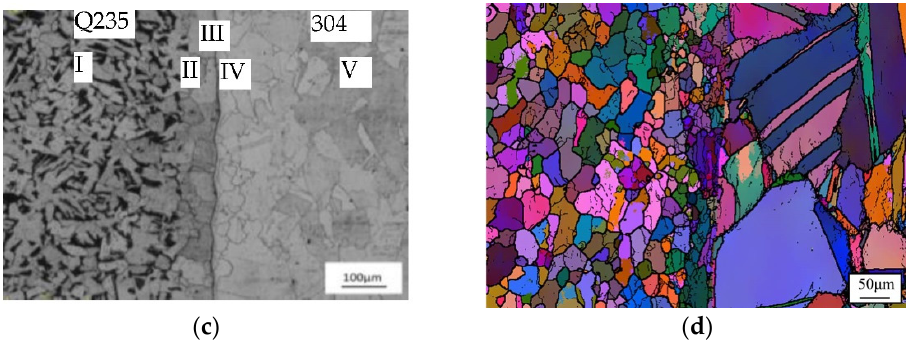
Figure 2. Optical microstructure of a bonded joint near the interface: ( a ) the microstructure of Q235 before bonding; ( b ) the microstructure of 304 before bonding; ( c ) the microstructure of a bonded joint; and ( d ) the orientation distribution of grains near the interface by EBSD.